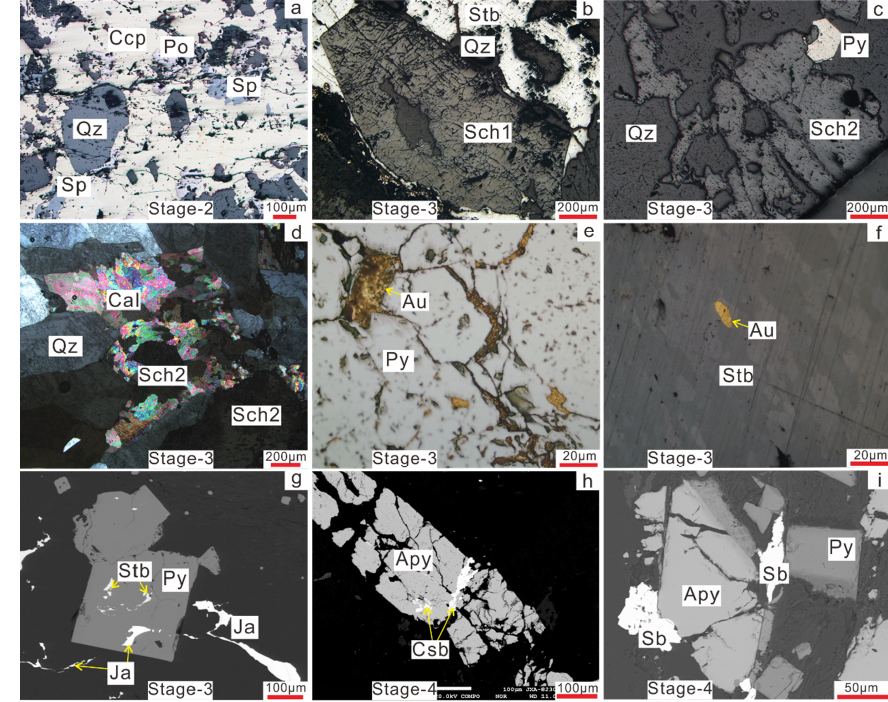
Figure 7. Typical photomicrographs of the Longshan Sb-Au deposit. ( a ) Stage-2 chalcopyrite associated with sphalerite and pyrrhotite; ( b ) Stage-3 euhedral Sch1 scheelite cemented by stibnite; ( c ) Stage-3 Sch2 scheelite associated with pyrite; ( d ) Stage-3 Sch2 coexisted with calcite and quartz; ( e ) Stage-3 native gold associated with euhedral-subhedral pyrite; ( f ) Stage-3 native gold associated with stibnite; ( g ) Stage-3 Pyrite associated with stibnite and jamesonite; ( h ) Stage-4 euhedral-subhedral arsenopyrite replaced by chalcostibite; ( i ) Stage-4 euhedral arsenopyrite replaced by native antimony. Sp = sphalerite; Ccp = chalcopyrite; Po = pyrrhotite; Qz = quartz; Stb = stibnite; Sch1 = scheelite type1; Sch2 = scheelite type2; Py = pyrite; Cal = calcite; Au = native gold; Ja = Jamesonite; Csb = chalcostibite; Sb = native antimony; Apy =